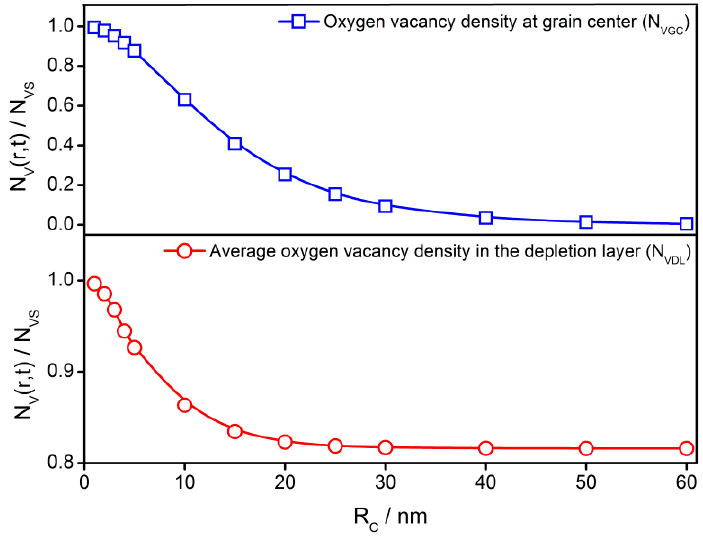
Figure 13. The grain size effect on the steady-state oxygen vacancy density at the grain center ( N VGC ) and average steady-state oxygen vacancy density in the depletion layer ( N VDL ).